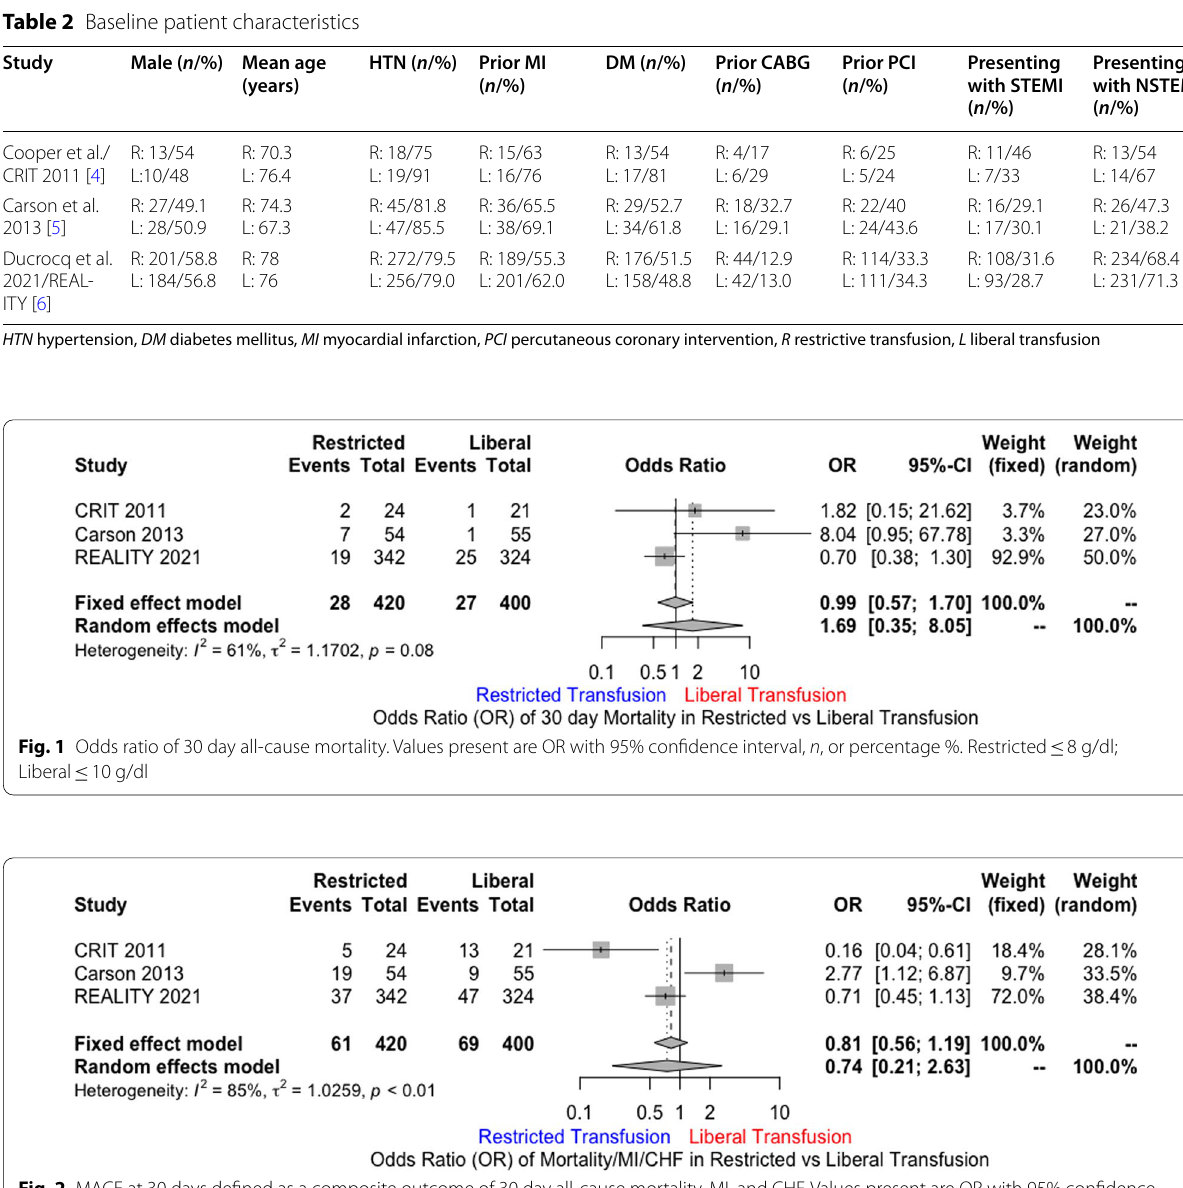
8 g/dl; Liberal 10 ≤ ≤